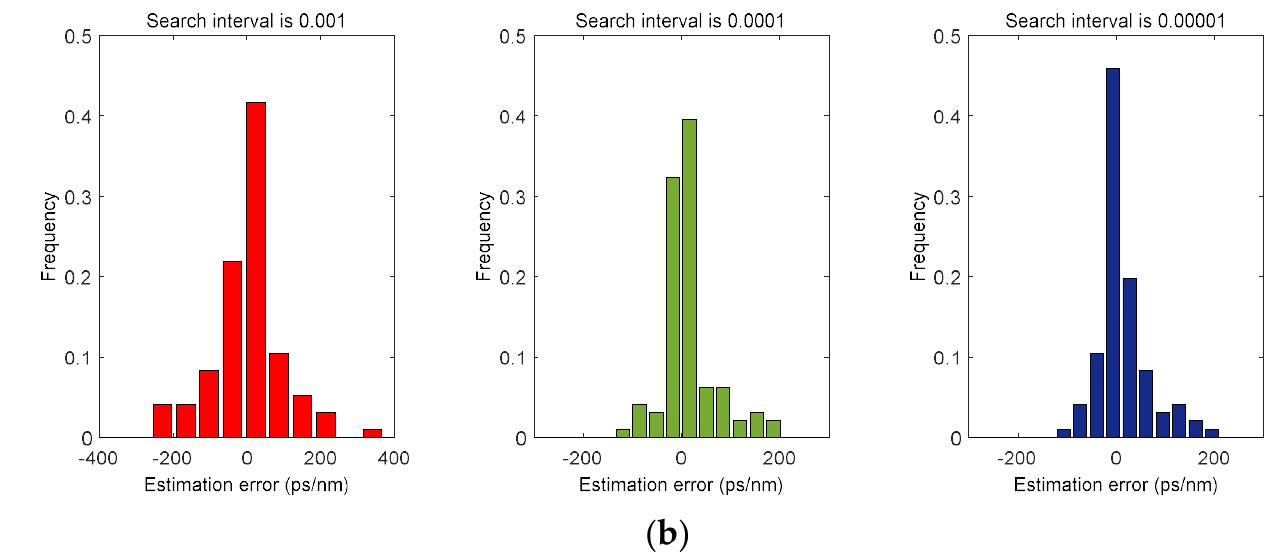
Figure 8. CD estimation error distribution of PM-QPSK signal corresponding to different search intervals when the sampling points are ( a ) 2048 and ( b ) 4096.